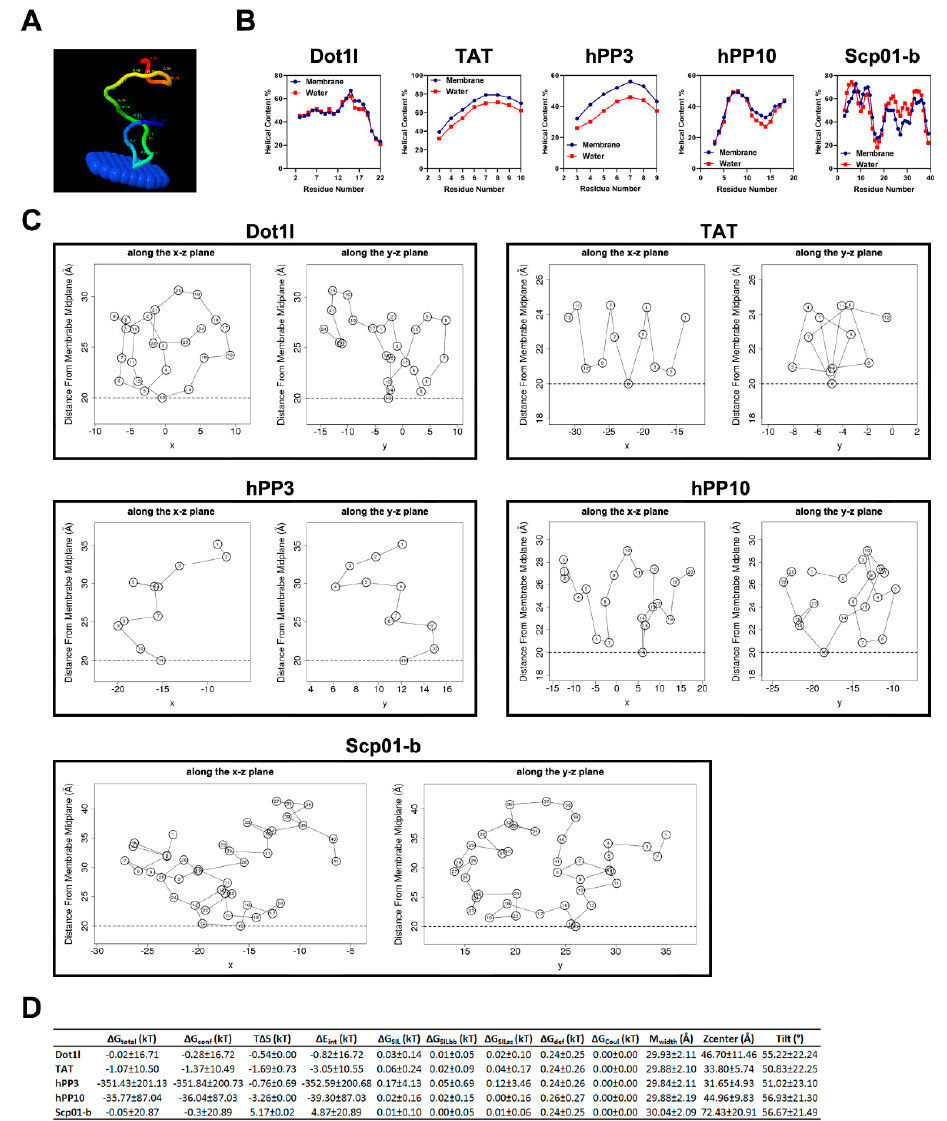
Figure 4. Dot1l peptide–membrane interaction prediction by the PPM and MCPep web server. ( A ) Dot1l peptide–membrane interaction prediction by PPM web server. ( B ) Di ff erent CPP / secondary structure propensity prediction in water and lipid bilayers (membrane) environments using the MCPep web server. ( C ) The average location of the amino acids of di ff erent CPPs (Dot1l, hPP3, hPP10, and Scp01-b) in the membrane on the surface. The horizontal dashed lines indicate the location of the phosphate groups of the lipid polar heads (membrane includes 30% charged lipids). ( D ) Thermodynamic characteristics for Dot1l peptide in surface configurations (all values presented as means ± SE).